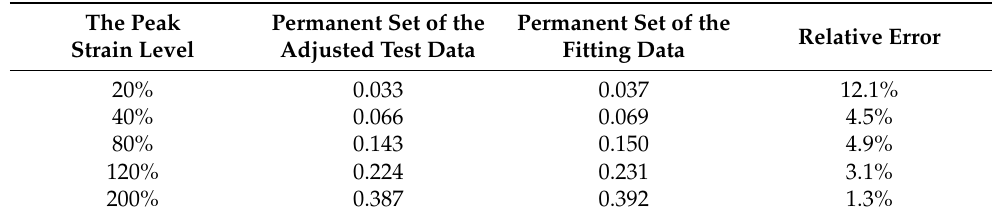
Table 3. The relative errors of permanent set between the adjusted test data and the fitting data at different peak strain levels for the carcass rubber and belt rubber.